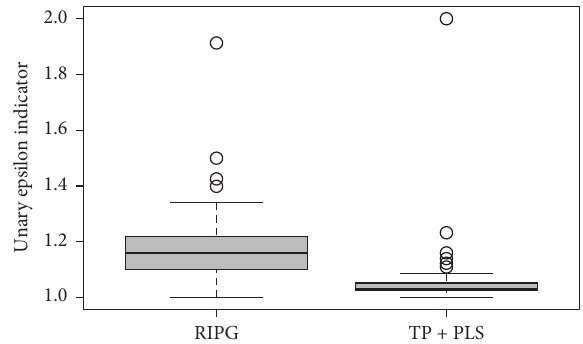
Figure 4: Box plot showing the unary epsilon indicator in a biobjective